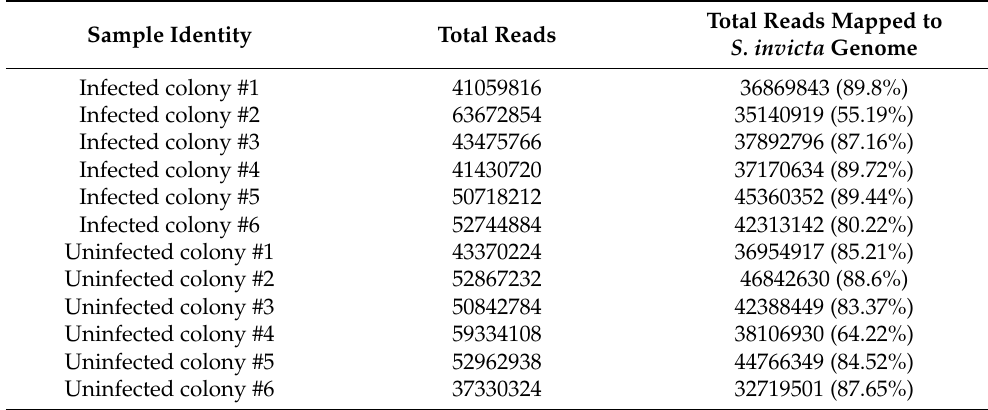
Table 1. Total reads generated with Illumina sequencing and total reads and that mapped to the S. invicta reference genome (percentage of total